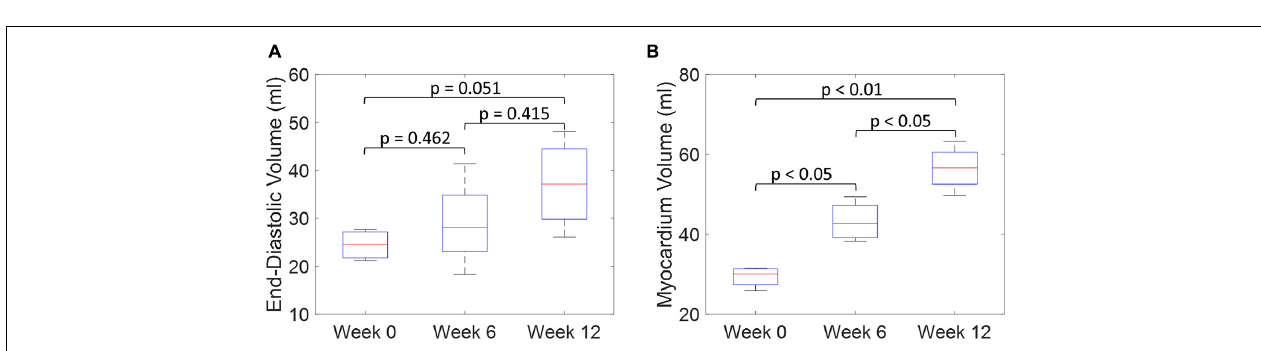
FIGURE 7 | A comparison of the LV geometries before and after exercise-induced growth. (A–C) MRI short-axis views of the LVs at weeks 0, 6, and 12 during exercise training. (D,E) Long-axis views comparing weeks 0–6 and 12 LV geometries. (F,G) Short-axis views comparing weeks 0–12 LV geometries. Rigid registrations were performed between the two geometries in panels (D–G) .